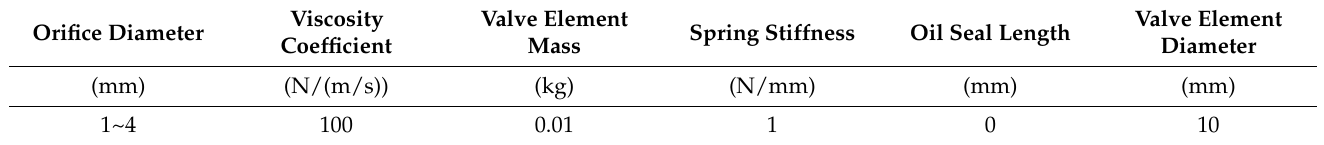
Table 1. Simulation parameters—group